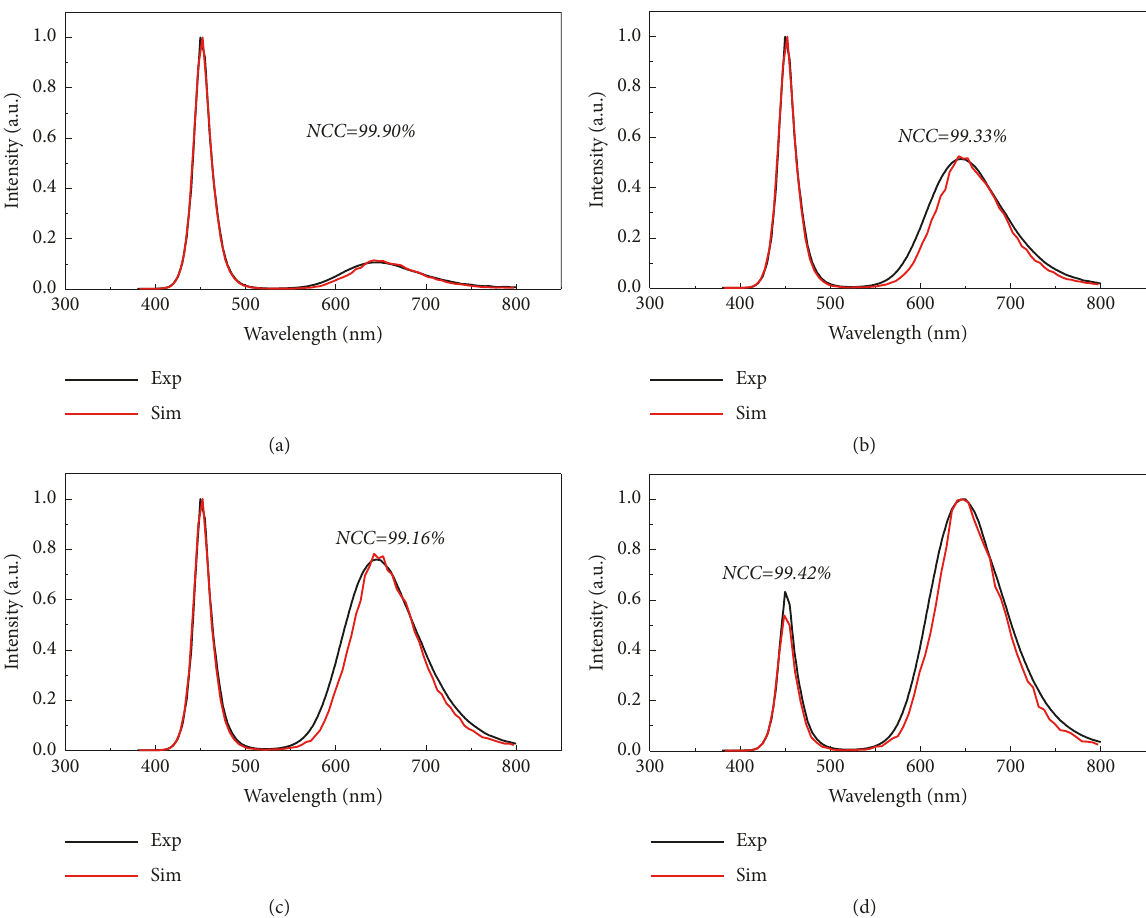
Figure 10: Spectrum power distribution of simulation and experiment at different mass ratio of red phosphor films (a) 0.05:1; (b) 0.1:1; (c) 0.15:1; (d) 0.2:1.